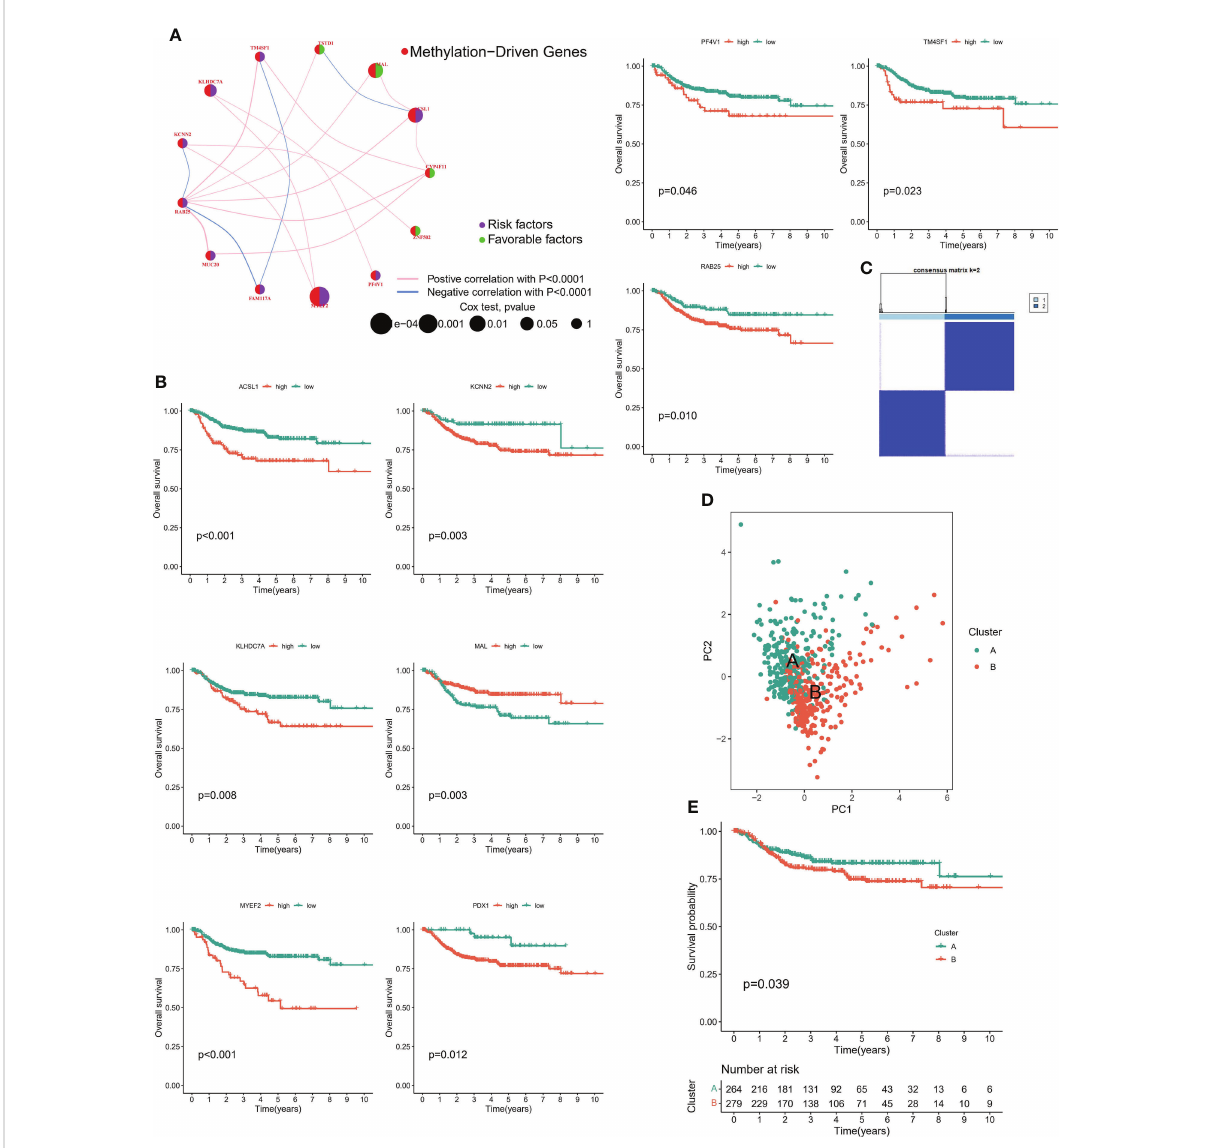
FIGURE 3 Methylation-driven associated subtypes. (A) Network diagram showing the prognostic signi fi cance and relevance of methylation-driven genes. (B) Prognostic value of methylation driven genes. (C) Consensus Matrix for unsupervised cluster analysis. (D) PCA analysis showed the distribution of different subtypes. (E) K-M curves showed the clinical outcomes among different